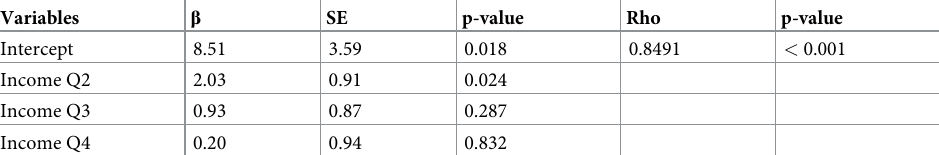
Table 4. Spatial auto-regression model for the relationship between community noise level and per capita income